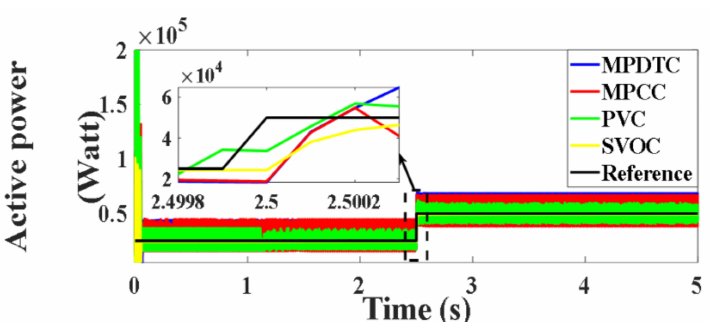
Figure 191. Comparison between active powers of four techniques